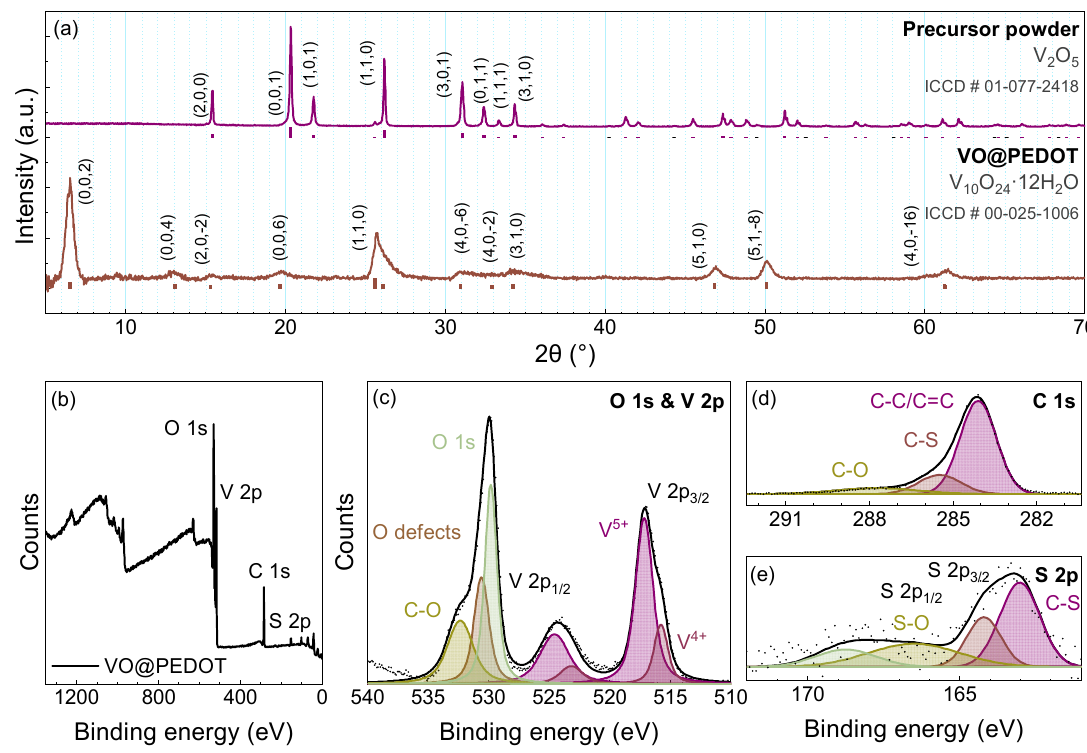
Figure 1. XRD patterns of the powders of the precursor V 2 O 5 powder and VO@PEDOT composite ( a ); XPS survey spectrum of VO@PEDOT powder ( b ); XPS spectra of VO@PEDOT powder in O 1s and V 2p ( c ), C 1s ( d ), and S 2p regions ( e ).